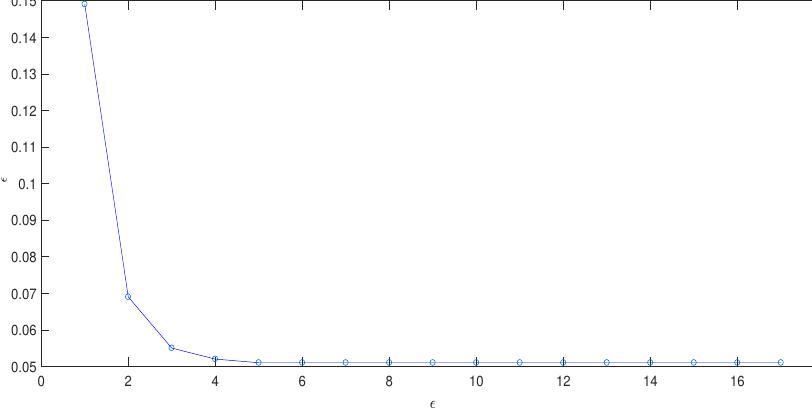
Figure 4. The orbits of the norm of synchronization errors (cid:107) e k ( t ) (cid:107) .